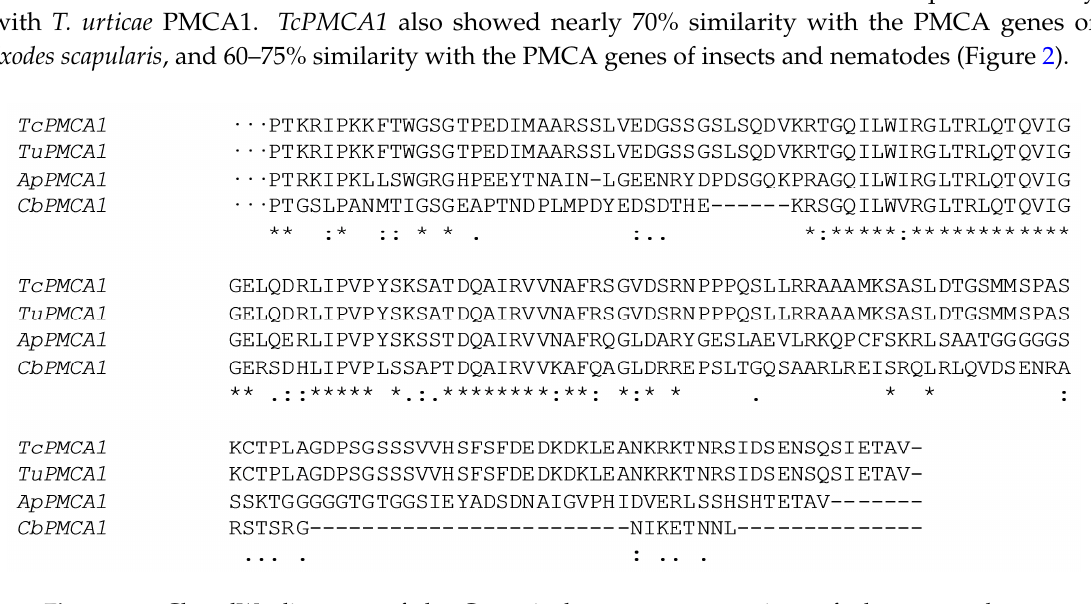
Figure 2. ClustalW alignment of the C-terminal sequence comparison of plasma membrane Ca 2+ -ATPase 1 ( PMCA1 ) obtained from different species. Alignment of the sequences of the PMCAs , starting after the last (10th) putative membrane-spanning domain and ending at the last residue. Residues that are completely conserved are marked with an asterisk (*); those that are highly conserved are indicated by colon (:); while similar residues are indicated by a dot (.). “-” represents interval. PMCA1 sequences used in the alignment are as follows: TcPMCA1 , Tetranychus cinnabarinus ; TuPMCA1 , Tetranychus urticae ; ApPMCA1 , Acythosiphon pisum ; and CbPMCA1 , Caenorhabditis briggsae . The PMCA2 sequences used in the alignment are as follows: TcPMCA2 , Tetranychus cinnabarinus ; TuPMCA2 , Tetranychus urticae ; IsPMCA , Ixodes scapularis ; and CbPMCA1 , Caenorhabditis briggsae .